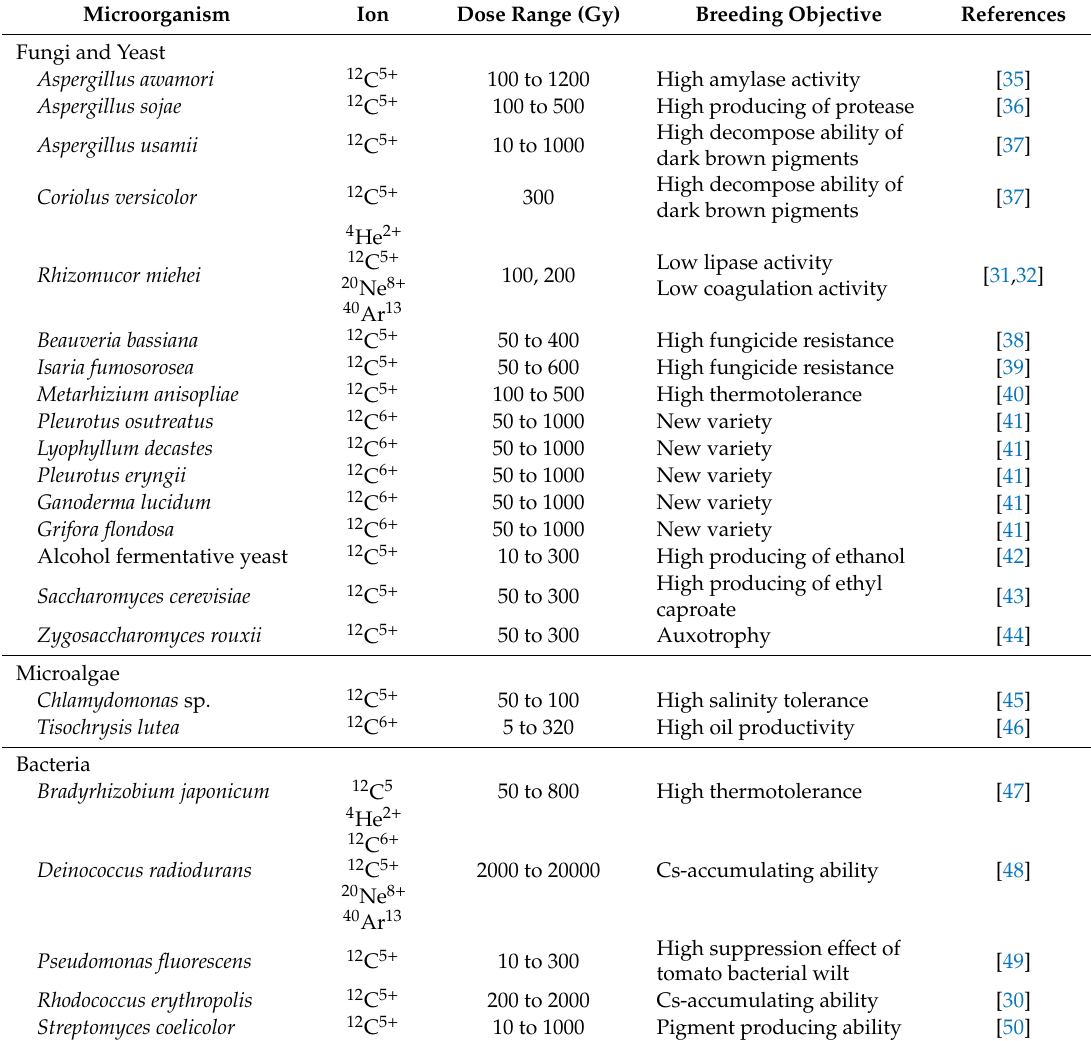
Table 4. Breeding of microorganisms using ion-beam breeding technology at the Takasaki Ion Accelerators for Advanced Radiation Application